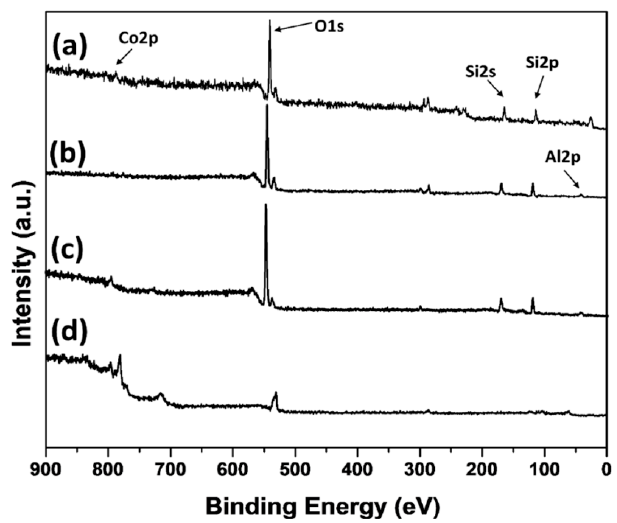
Figure 7. Survey XPS spectra of the calcined ( a ) Co/NS, ( b ) Co/NS-Al-A, ( c ) Co/NS-Al-B and ( d ) Co/Al 2 O 3 catalysts.